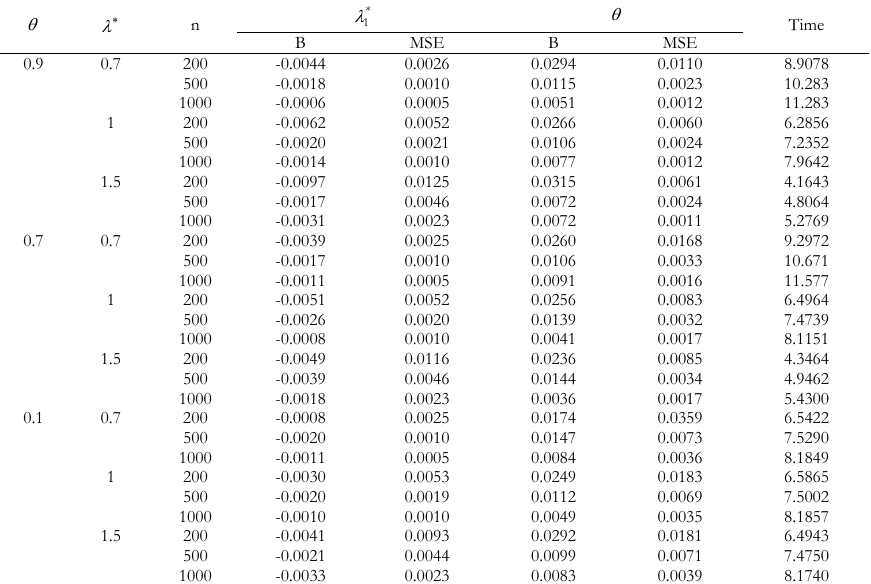
Exponential distribution: complete